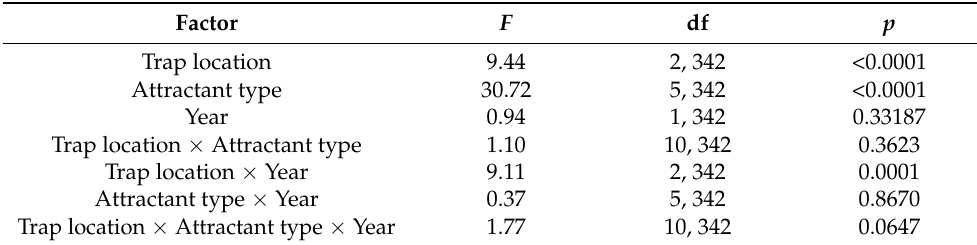
Table 4. Three-way analysis of mean Rhyzopertha dominica captures in Lindgren traps baited with six different attractant types, over two years, at three different locations using each trapping period as a replicate.